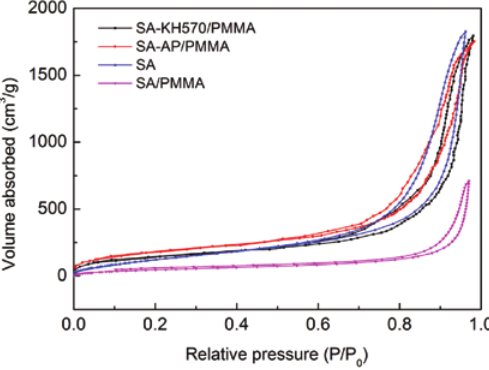
adsorption/desorption isotherms of silica aerogel (SA) Figure 3: N 2 and composites.